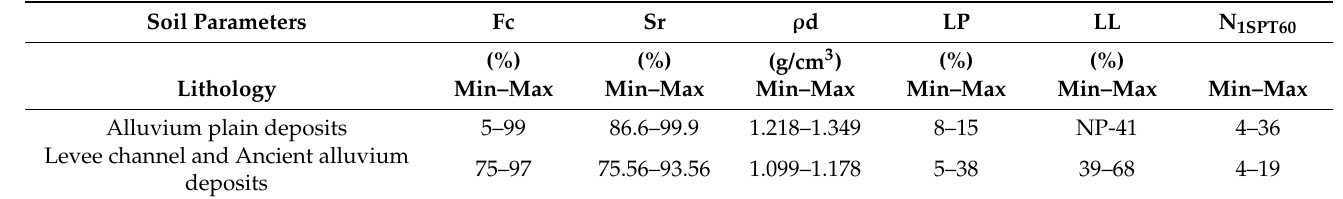
Table 4. Statistical soil parameter analysis results of “ground zero” of the urban area of the city of Portoviejo.